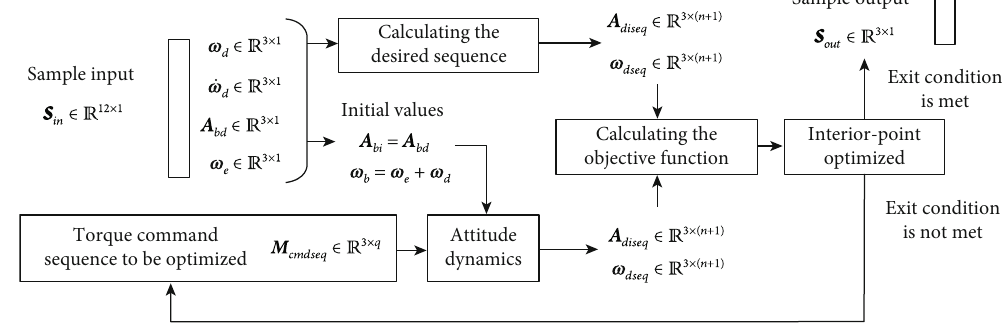
Figure 3: The algorithm of sample creation. Table 2: Input range of sample and the neural